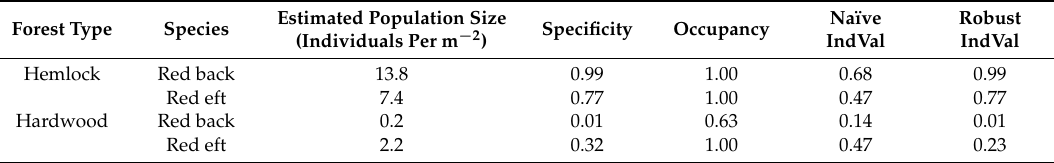
Table 2. Population size, specificity, occupancy, and indicator value (IndVal) estimates for red backs ( Plethodon cinereus ) and red efts ( Notopthalmus viridescens ) in hemlock and young mixed deciduous forests in the Hemlock Removal Experiment (HF-HeRE) at the Harvard Forest long-term ecological research (LTER) site (HFR). Estimates are based on data collected in July 2014 from two 0.81-ha plots representing each forest type (HC and HD in Figure